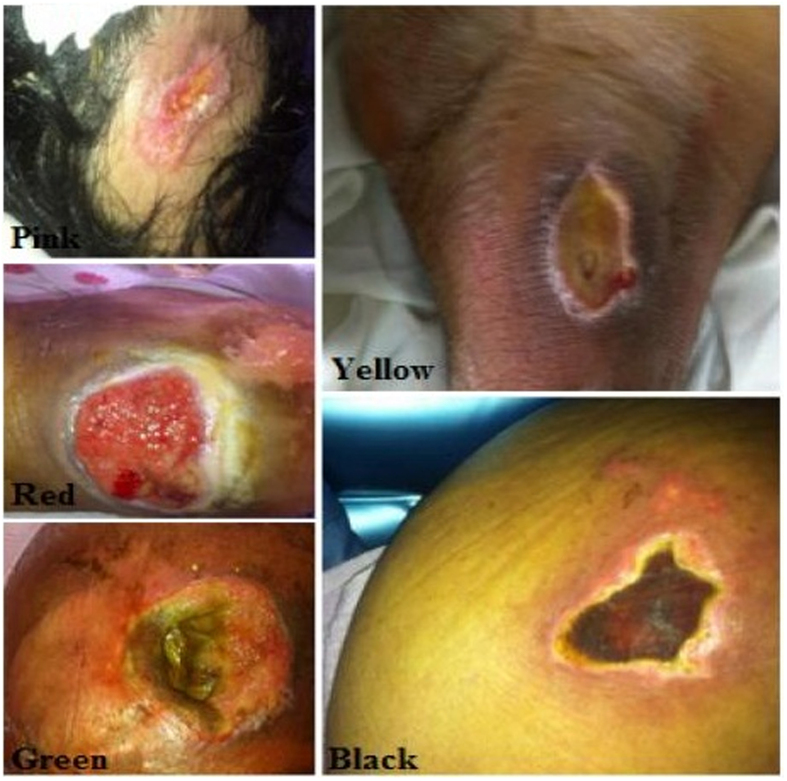
Colorielle classification scale wounds.